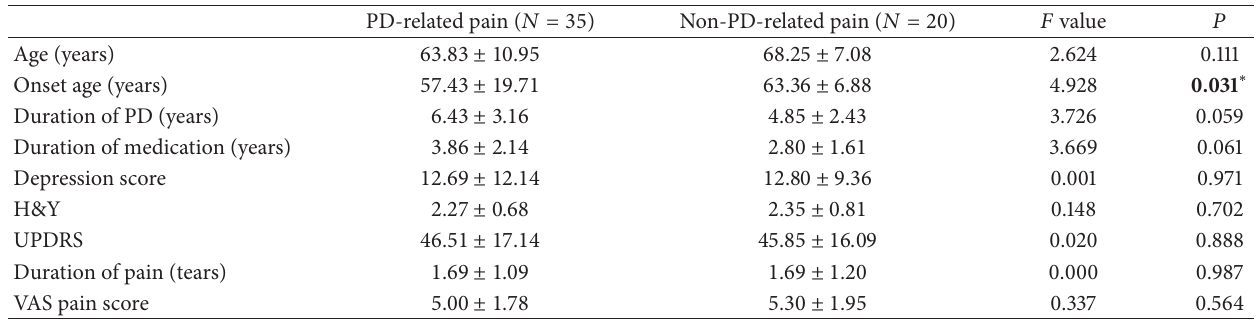
Table 5: Factors between PD-related pain and non-PD-related